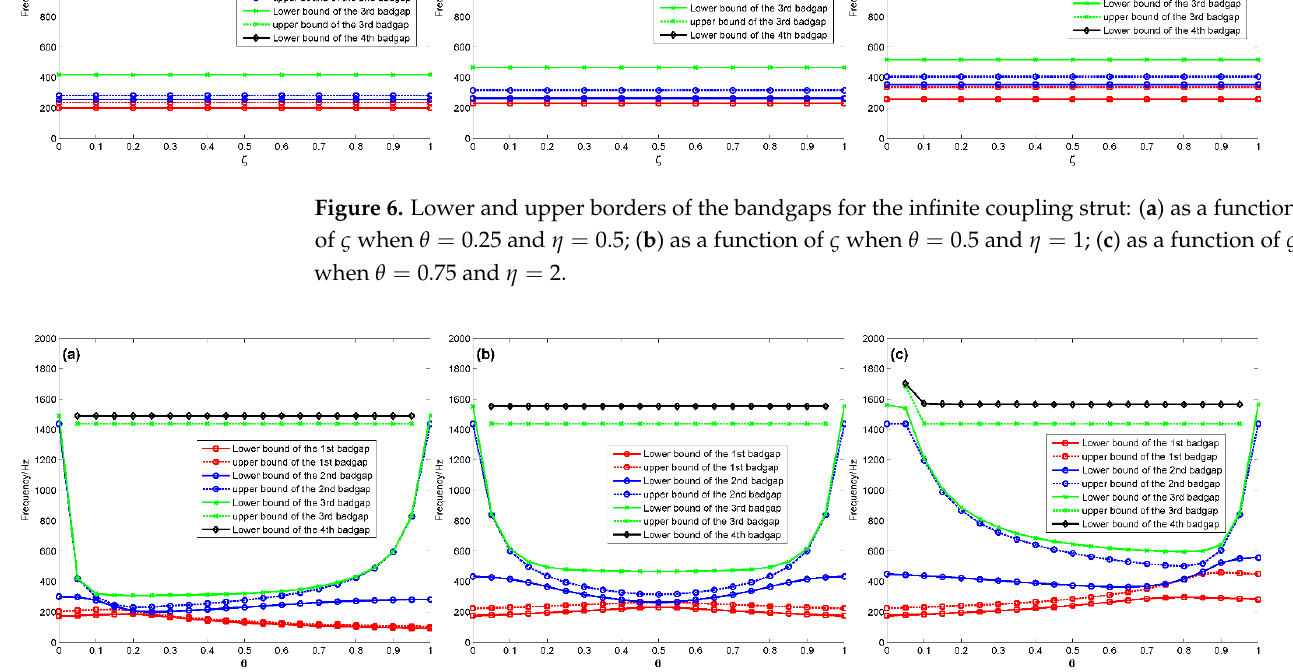
Figure 7. Lower and upper borders of the bandgaps for the infinite coupling strut: ( a – c ) as a function of θ when η = 0.25, η = 1 and η = 4, respectively.